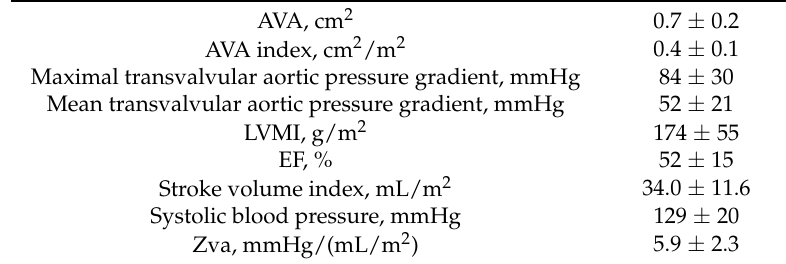
Table 2. Echocardiographic parameters, systolic blood pressure and valvulo-arterial impedance. AVA, cm 2